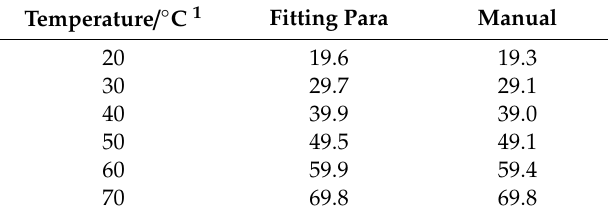
Table 1. The influence of temperature for di ff erent methods to obtain the parameters of A and B.